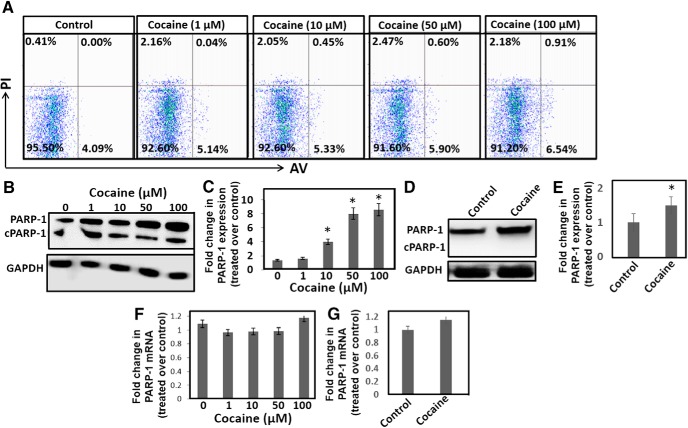
Cocaine exposure induces PARP-1 protein expression without increasing mRNA levels. A, Differentiated SH-SY5Y cells were exposed to different concentrations of cocaine overnight and apoptosis was measured by flow cytometry using AV- as an early apoptosis marker and PI- as the late apoptotic marker. After cocaine treatment, cells were harvested and stained with FITC-conjugated AV/PI and analyzed by flow cytometry. Representative dot blot data showing percentage of cells stained positive for AV, PI, and AV + PI. B, Differentiated SH-SY5Y cells were treated with varying concentrations of cocaine. Cells were harvested, and cell lysates were electrophoresed on denaturing acrylamide gels and transferred onto nitrocellulose membrane by electroblotting. Western blot analyses were performed using appropriate antibody and ECL kit. Representative data of PARP-1 expression in untreated and cocaine-treated cells. C, Densitometry of PARP-1 expression from three independent experiments. D, Mice were injected (i.p.) with a single dose of cocaine (20 mg/kg weight of mice, i.p.) or saline. Animals were sacrificed and NAc was isolated. Lysates prepared from the NAc tissues were subjected to western blot analysis. (E) Relative expression of PARP-1 in the NAc of cocaine-treated mice (n = 6) compared to the NAc of saline-treated mice (n = 6). *p < 0.05 for the comparison of cocaine-treated samples versus untreated controls. (F) Differentiated SH-SY5Y cells were treated with varying concentrations of cocaine overnight. Cells were harvested and total RNA was isolated. PARP-1 mRNA expression was measured by qPCR and was normalized to the levels of GAPDH mRNA. PARP-1 mRNA in cocaine-treated cells were expressed as fold changes over the untreated control cells based on ΔΔCt values. G, Mice were injected (i.p.) with a single dose of cocaine (20 mg/kg weight of mice) or saline. Animals were sacrificed and NAc was isolated. Total RNA was isolated from the NAc tissues and were subjected to qPCR. PARP-1 mRNA expression was normalized to the GAPDH mRNA levels and fold changes in PARP-1 mRNA in the NAc of cocaine-treated mice (n = 6) over the NAc of saline-treated mice (n = 6) were calculated based on ΔΔCt values.